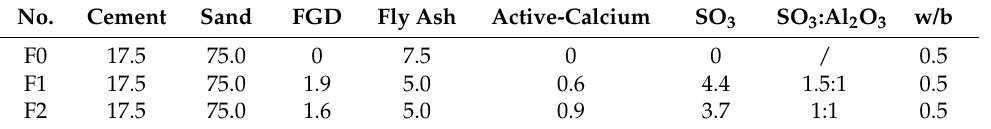
Table 2. Mix proportion of cement-fly ash-FGD-active-calcium aluminate mortar (wt/%).